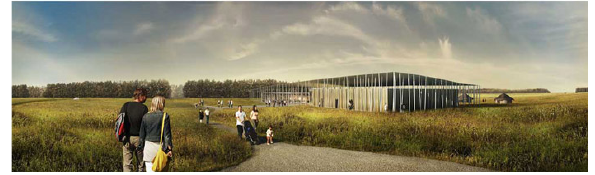
Figure 8 Proposed design for new Stonehenge visitor